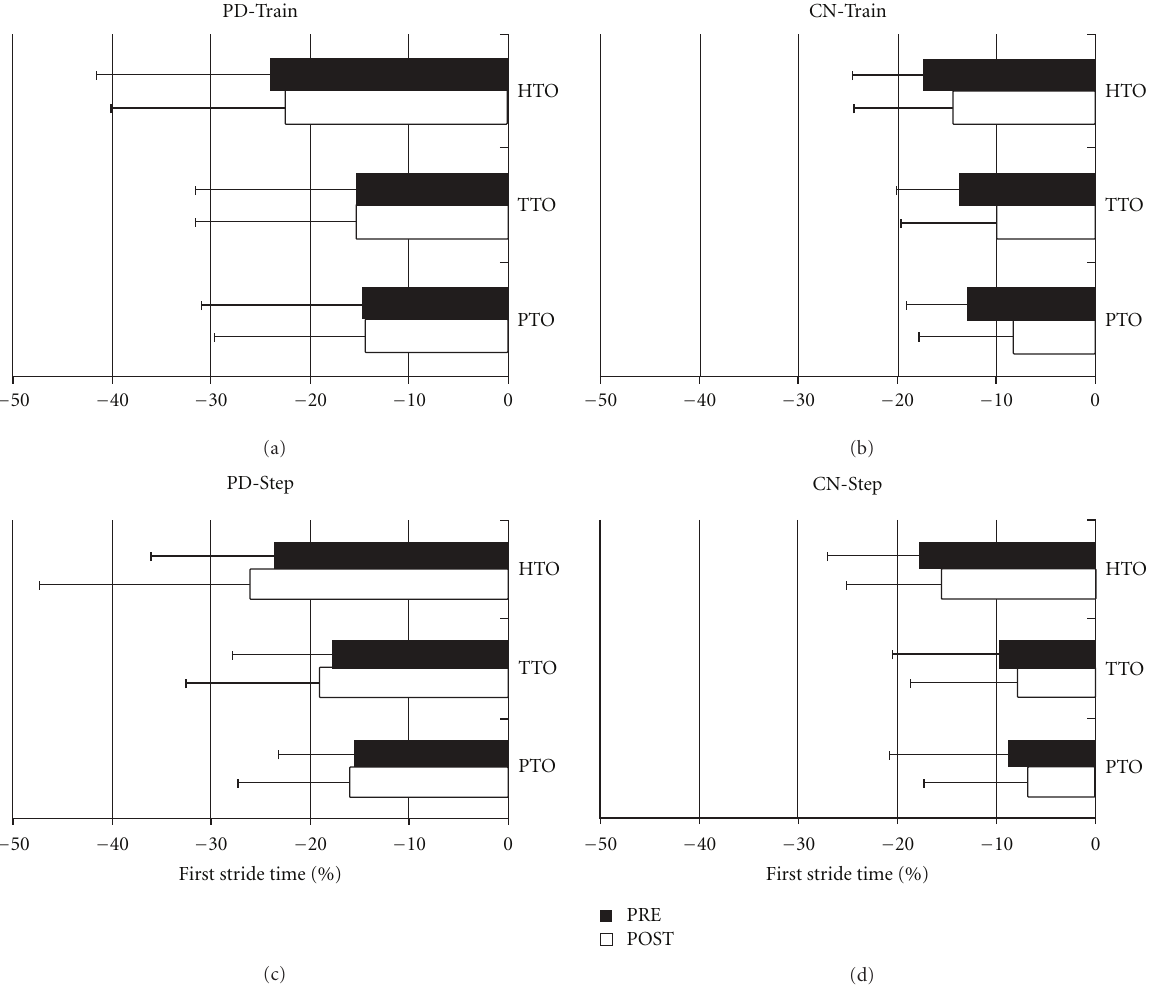
Figure 4: Onsets of Body Segment Rotations . Mean yaw rotation onset times of the head (HTO), trunk (TTO), and pelvis (PTO) relative to the turn onset (i.e., first foot rotation) are expressed as a percentage of the first stride of the turn for PD-Train (a), CN-Train (b), PD-Step (c), and CN-Step (d). Error bars are SDs. Table 2: Five-day rotating treadmill training results for the trained